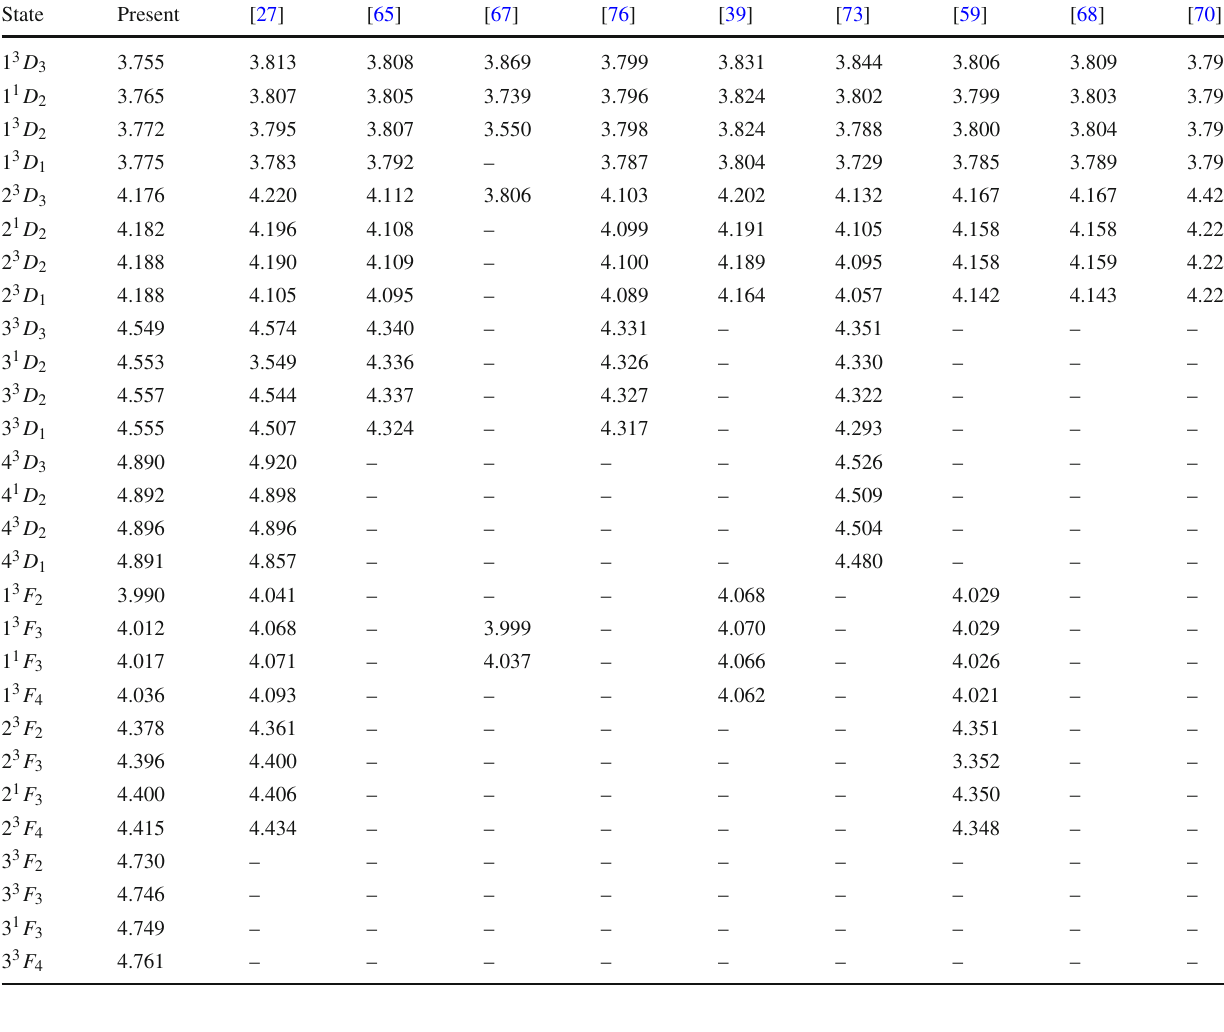
Table 3 Mass spectrum of D and F -wave charmonia (in GeV)